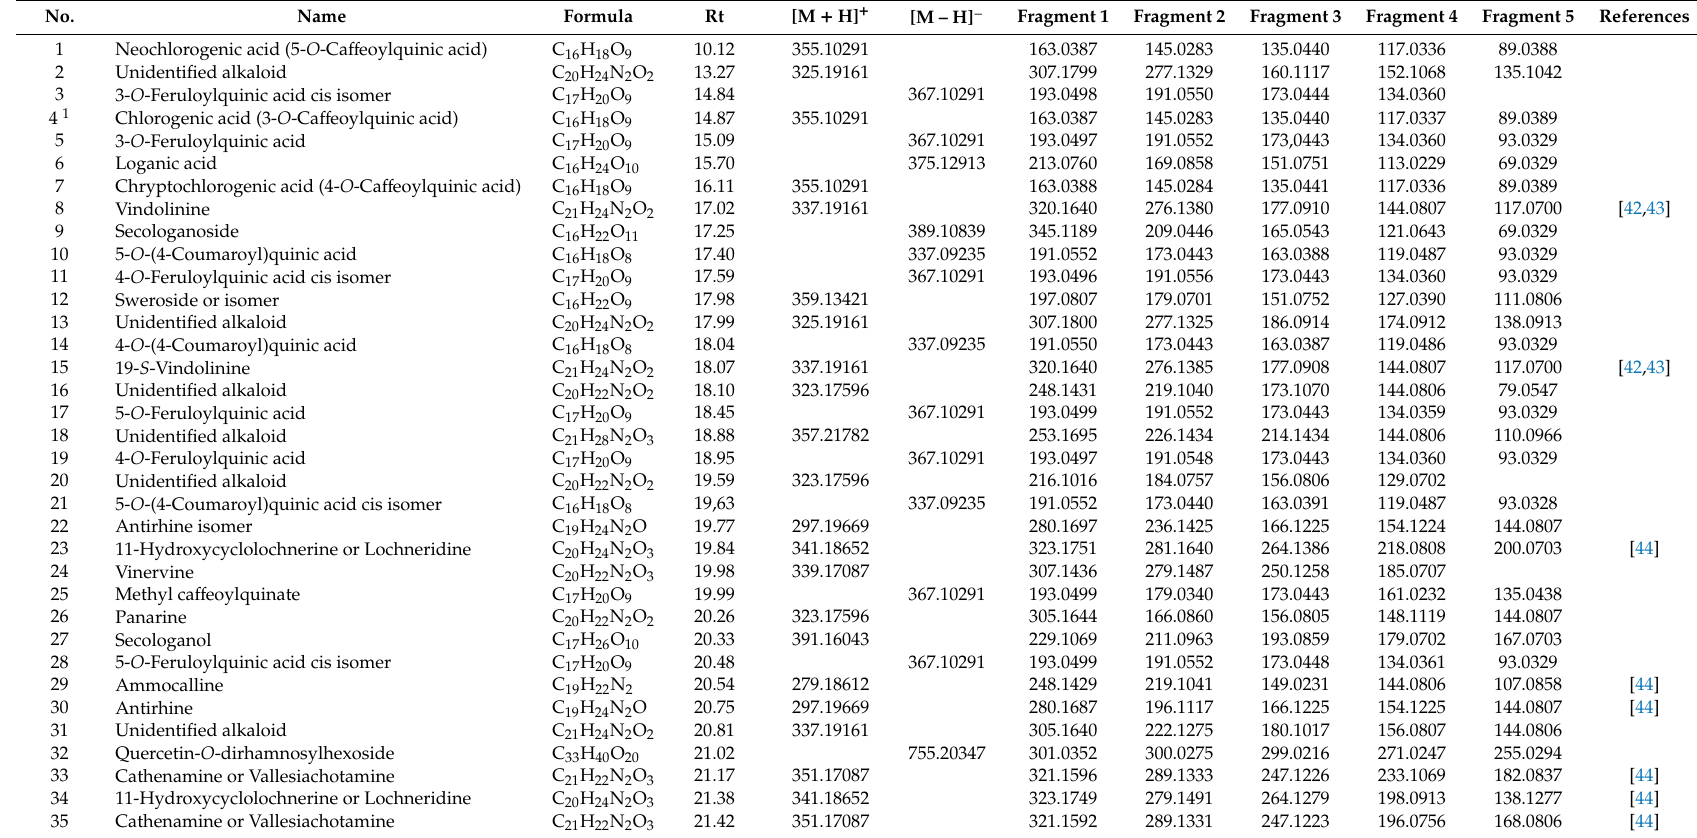
Table 11. Chemical composition of normal green shoot tissues of Catharanthus roseus